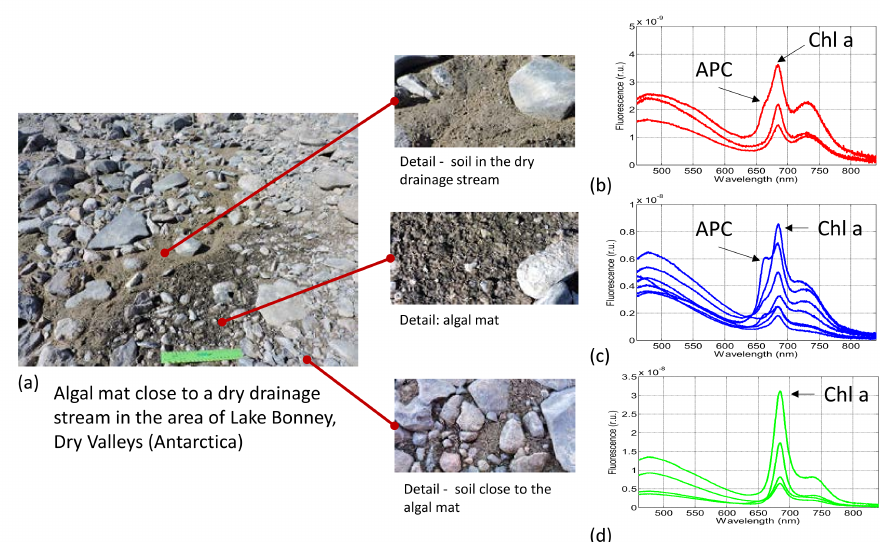
Figure 5. LIF spectra on algal mats close to a dry drainage stream (Lake Bonney area at Dry Valleys, Antarctica). ( a ) Picture of the examined area with algal mats. ( b ) Detail of the soil in the drainage stream and relevant LIF spectra. ( c ) Detail of the algal mat and relevant LIF spectra. ( d ) Detail of the soil close to the algal mat and relevant LIF